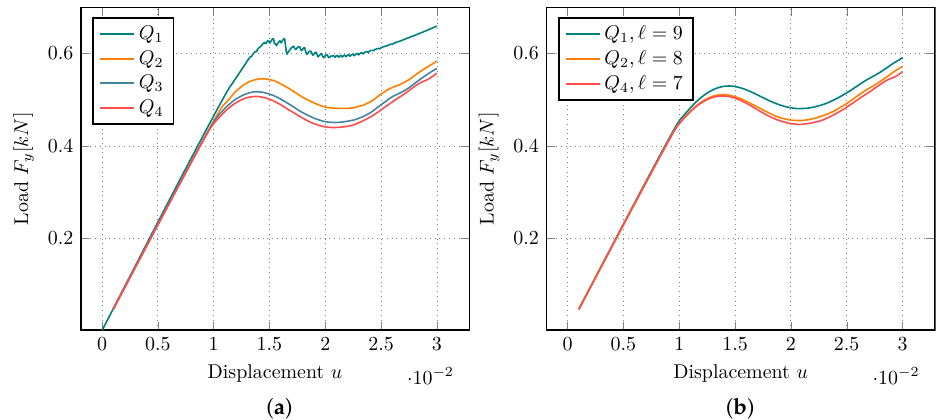
Figure 6. Different polynomial degrees for the anisotropic single-edge notched shear test with ε = 4 × 10 − 3 . ( a ) Refinement level (cid:96) is fixed at (cid:96) = 7. ( b ) Constant problem size of 790 k